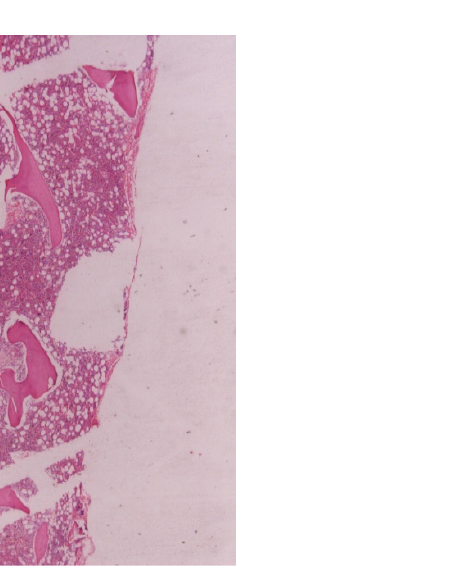
Figure 3. Fine needle biopsy of bone tissue from the tibial condyle shows Leishman – Donovan bodies within